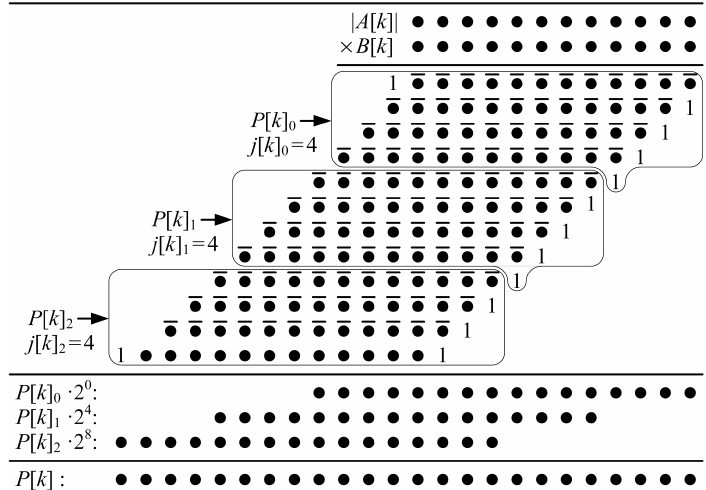
Figure 9. Proposed ( m × n )-bit KCM with two selectable coefficients, where m = n = 12, A [ k ] is a negative constant and B [ k ] is a signed variable. This example does not require any additional resources compared to a (12 × 12)-bit KCM with a single